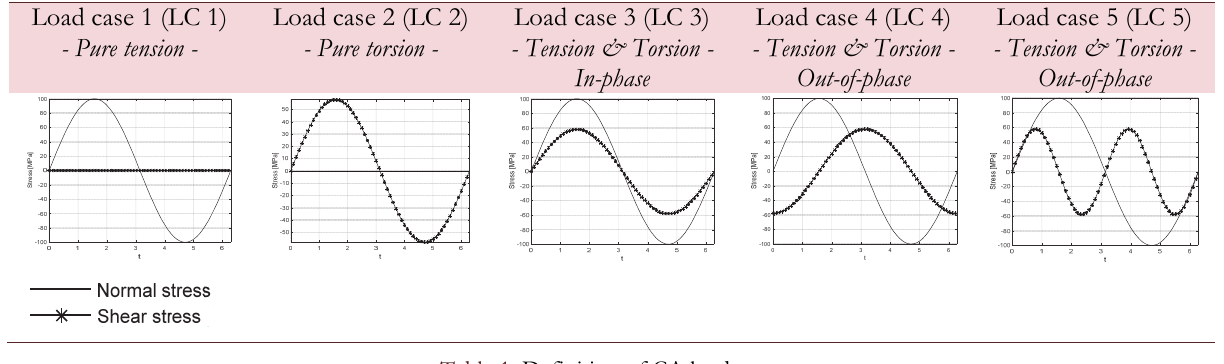
Table 1: Definition of CA load cases